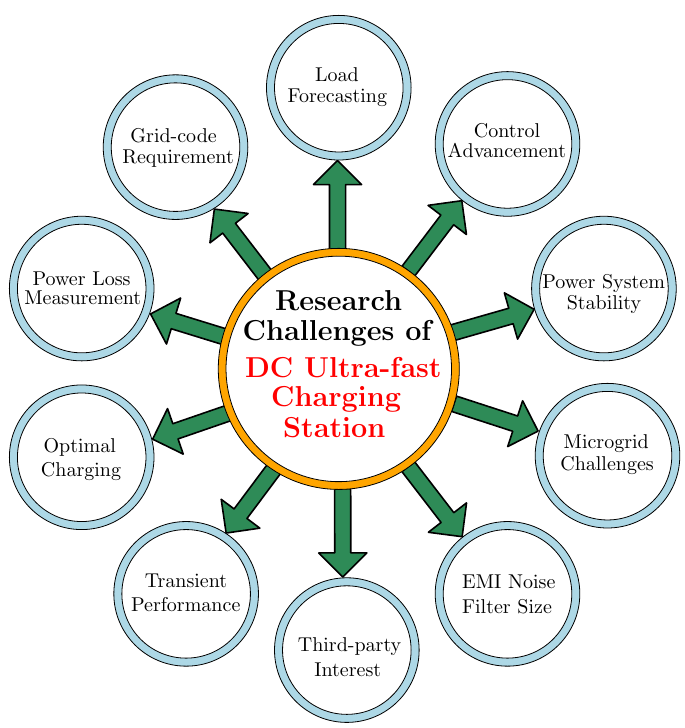
Figure 6. Research challenges in the DC ultra-fast charging